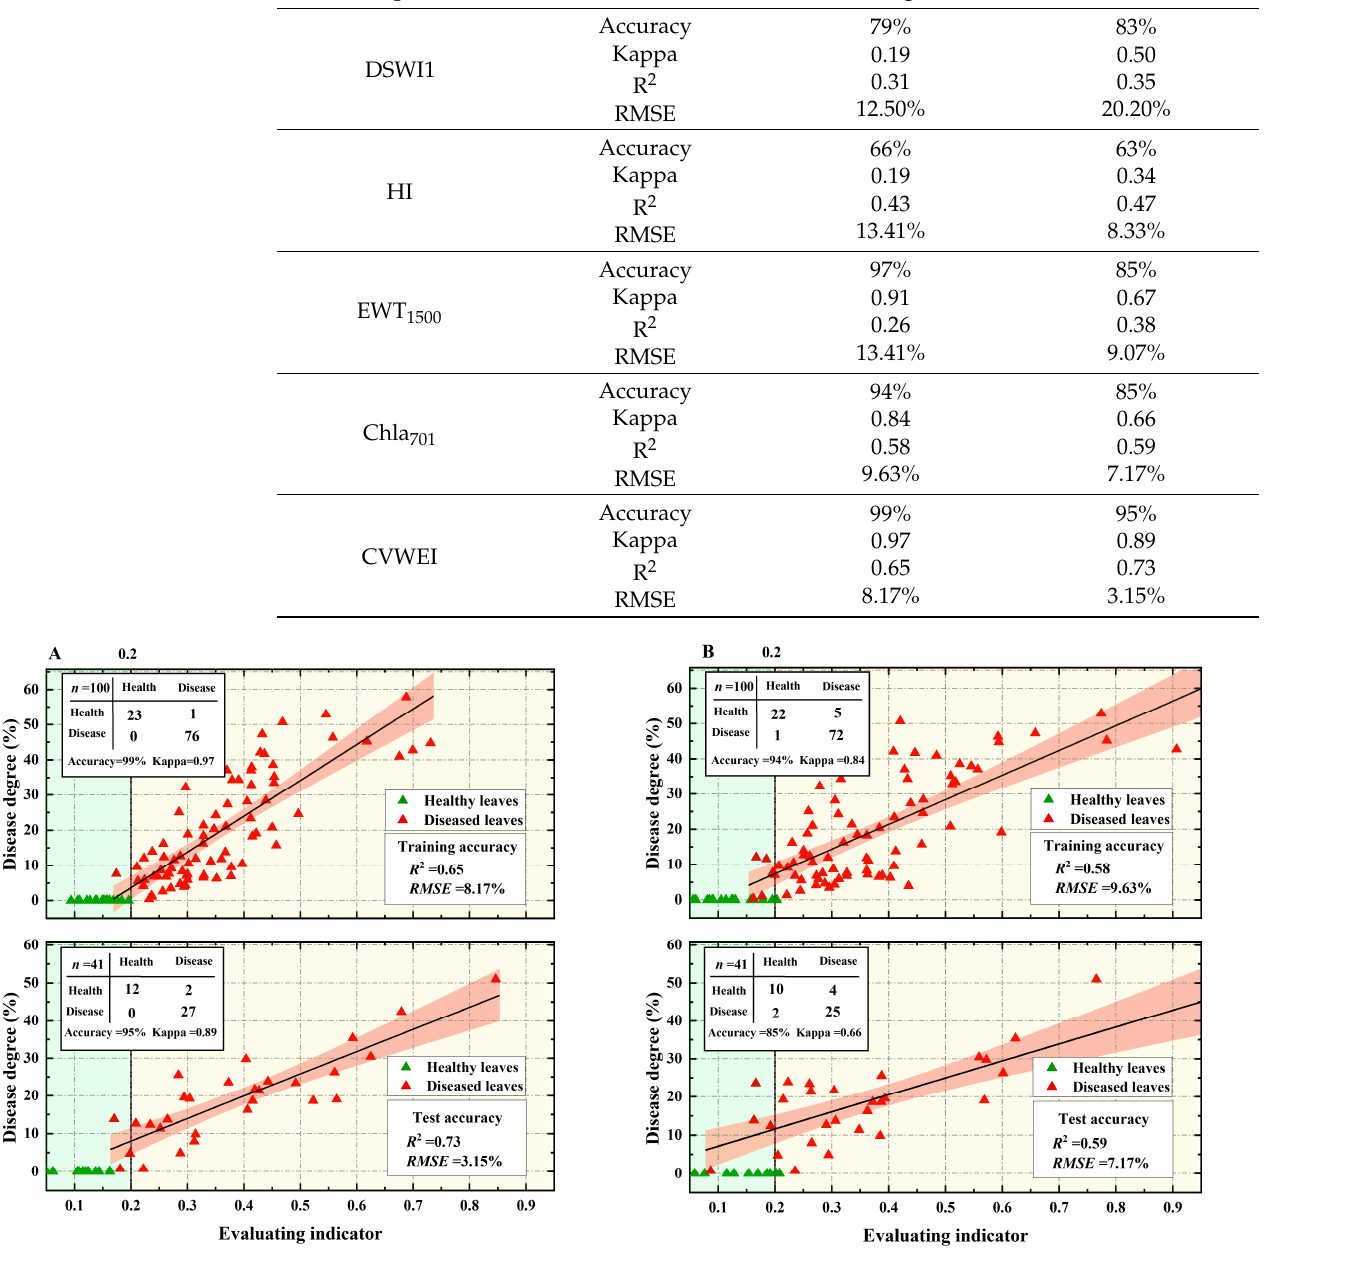
Table 5. Accuracy evaluation of the cotton VW early detection model. Input